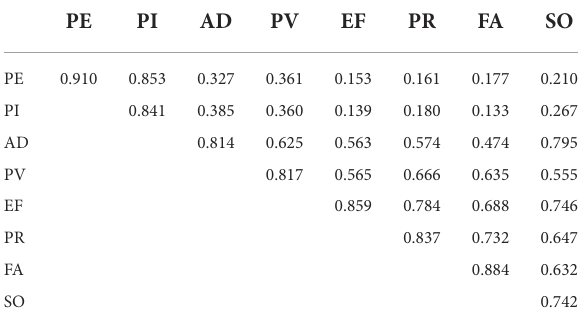
TABLE 4 Discriminant validity.